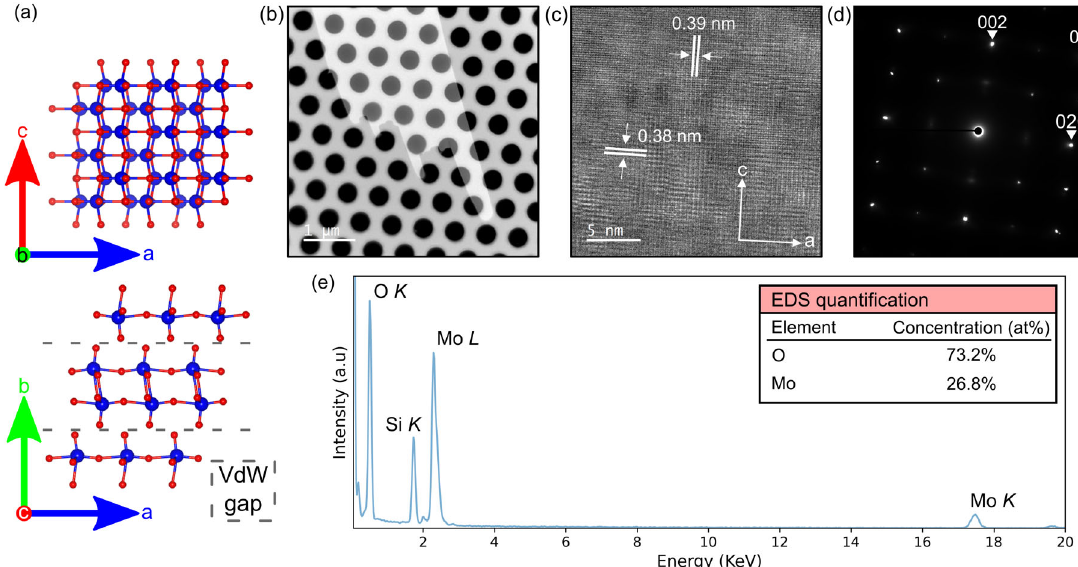
Fig. 1 Anisotropic structure of MoO 3 fl akes. a Crystal structure of MoO 3 in Pbnm notation, spheres in blue (red) represent Mo (O) atoms, the two different views belong to ca (top), and ba plane projection (bottom). b Low magni fi cation HAADF image of a mechanically exfoliated MoO 3 fl ake transferred over a porous SiN membrane, scale bar is of 1 μ m. c Atomic resolution HAADF image depicting the anisotropy between the in-plane ( a – c ) lattice parameters, scale bar is of 5 nm. d SAED pattern characteristic of the orthorhombic α - MoO 3 . e EDS spectrum taken at the fl ake shown in b